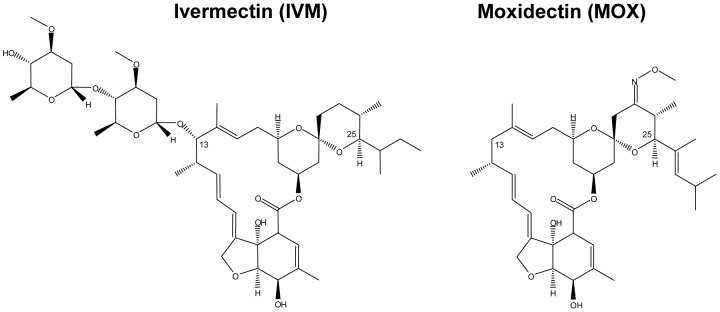
Comparison of chemical structures of ivermectin and moxidectin.Ivermectin is a mixture of B1a (substituent butyl on C25) and B1b (substituent isopropyl on C25) forms. The majority (more than 90%) of the drug is present as the B1a form.